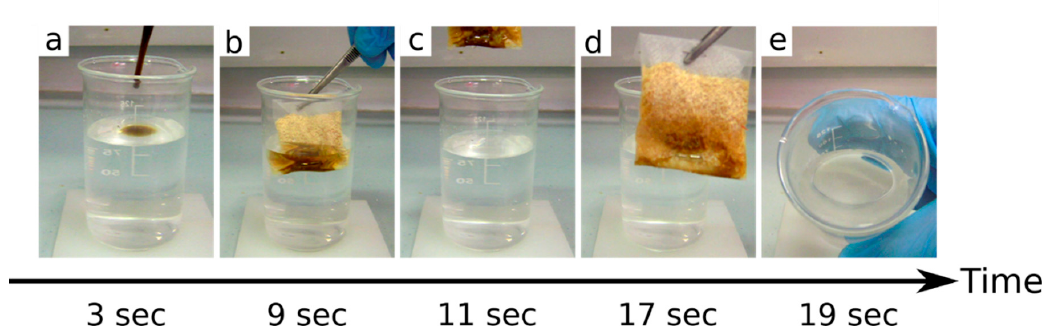
Figure 7. Oil adsorption steps in the water of Arundo donax fibers. ( a ) Crude oil drops are poured into water; ( b ) sorbent fibers are put into the beaker; ( c ) sorbent fibers are taken out and the crude oil drops disappear; ( d ) the oil remains trapped into the sorbent material; ( e ) the water is cleaned